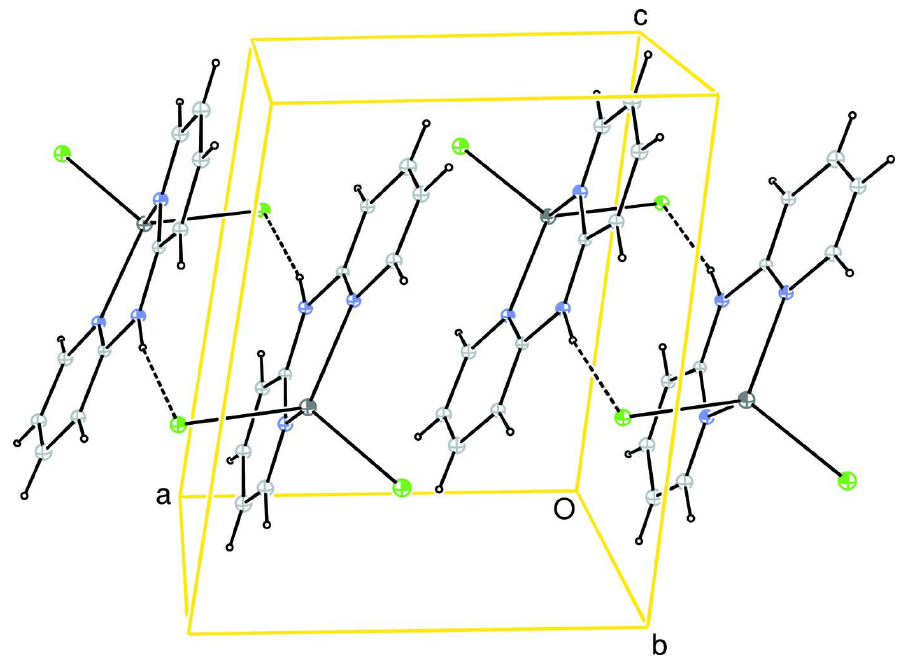
Figure 2 A packing diagram of the title compound. Hydrogen bonds are shown as dashed